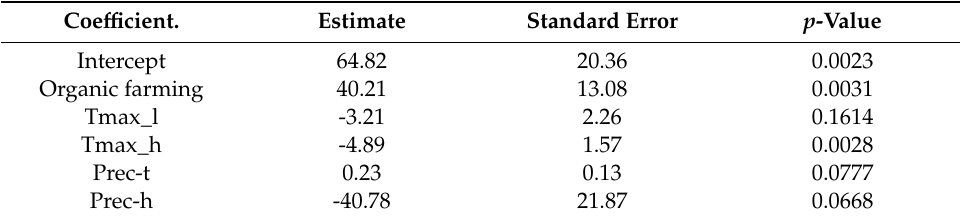
Table 4. Results of the bidirectional stepwise linear regression model.